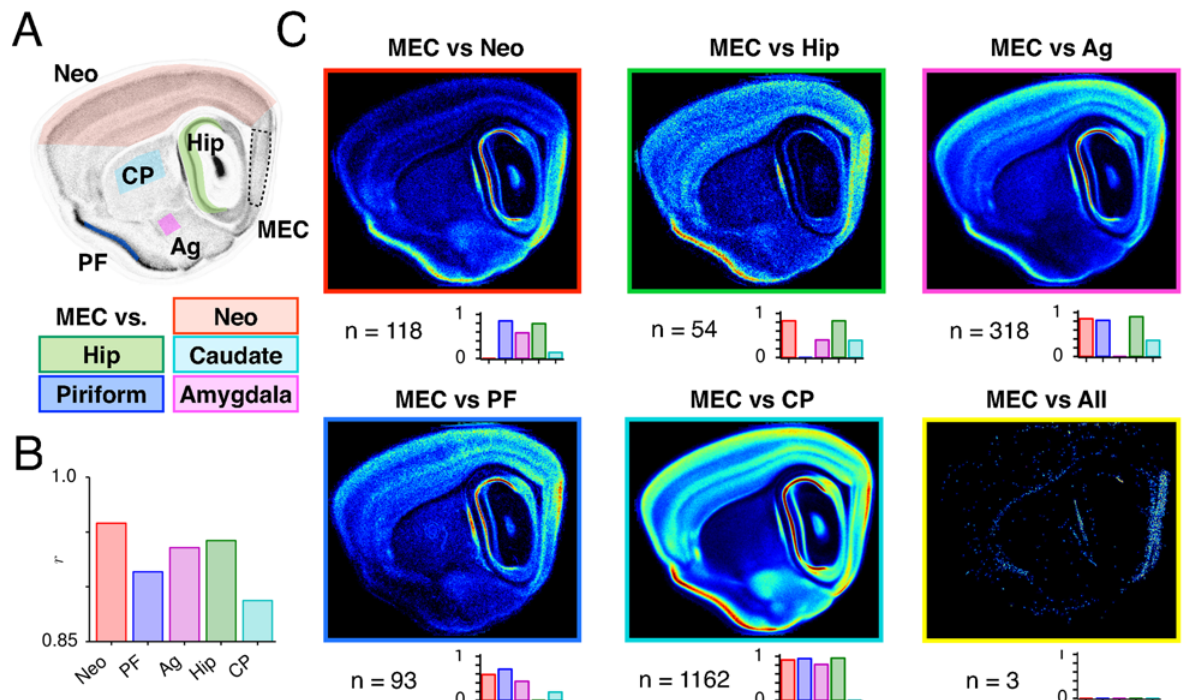
Figure 2. Identification of MEC-enriched genes. (A) Locations on the central reference image (Im refC ) for which mean pixel intensities (mINT) were extracted from the MEC, neocortex (Neo), hippocampus (Hip), piriform cortex (PF), caudate putamen (CP) and amygdala (Ag). (B) Bars indicate Pearson ’ s correlation coefficients between mINT MEC and mINT [OTHER] for all genes in the re-registered ABA data set. (C) Images show the average pixel intensities throughout sagittal sections corresponding to the central reference section of genes that have at least 4-fold higher mINT * in MEC than in neocortex (red frame), hippocampus (green), piriform cortex (blue), amygdala (magenta) or caudate putamen (cyan) individually. Just 3 genes are expressed at higher levels in MEC than other brain regions pooled together (yellow frame). Lower bar charts indicate the proportion of genes in each list that are expressed in each other region, given the same inclusion criteria. * Inclusion criteria: mINT MEC (cid:1) 2 and mINT normMEC (cid:1) 0.8 ( (cid:1) 0.99 if mINT MEC < 5) and mINT OTHER < 5.